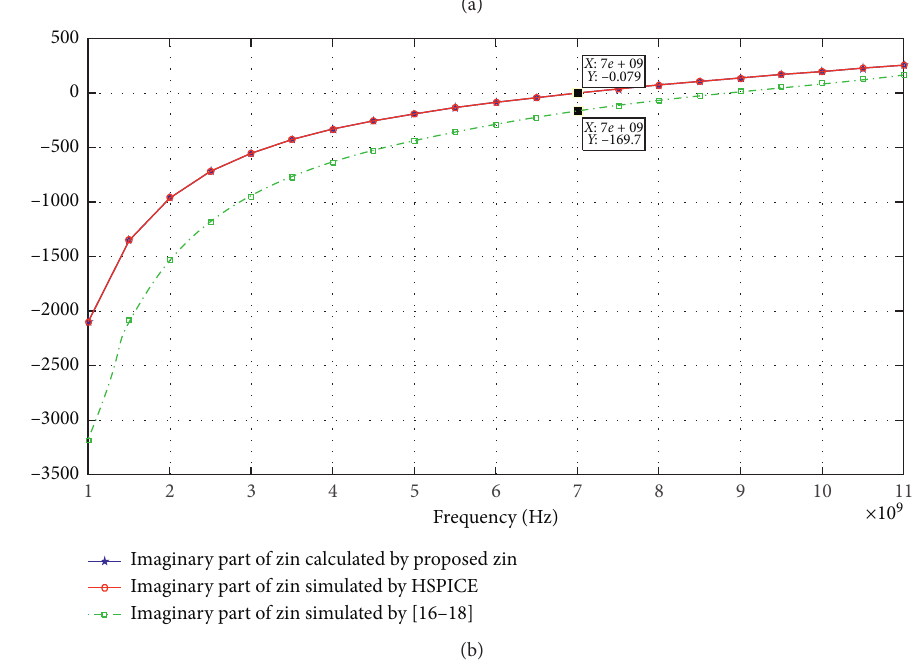
Figure 7: Comparison of the real part and imaginary part of input